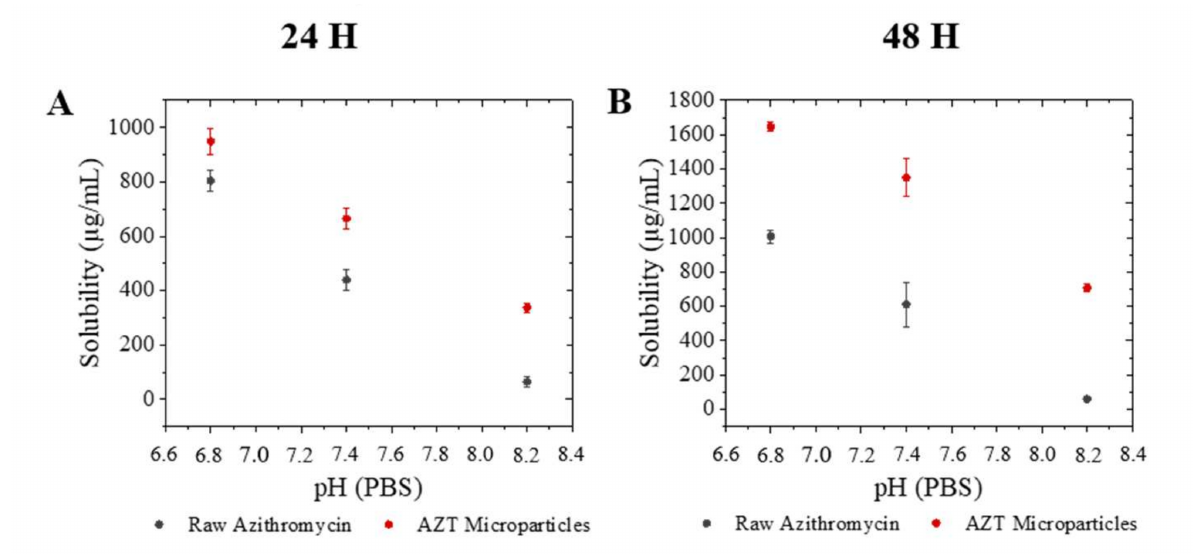
Figure 4. Equilibrium solubility: Raw azithromycin and azithromycin microparticles at different pH (6.8–8.2), ( A ) 24 h; ( B ) 48 h (mean ± SD, n =